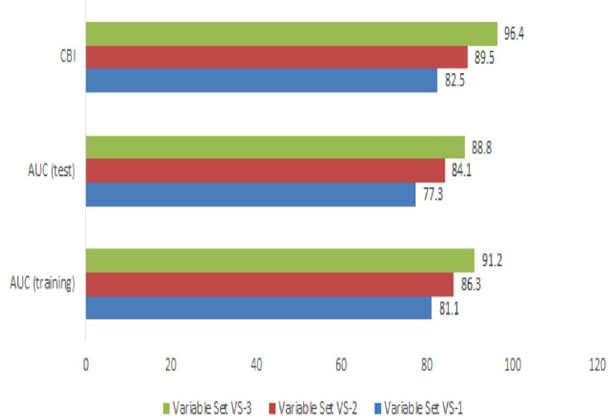
Figure 1. Area Under Curve (AUC) and Continuous Boyce Index (CBI) comparing prediction accuracy of Maxent-based models in Snowdonia National Park using three predictor variable sets at 1 km (VS-1), 300 m (VS-2) and 50 m (VS-3)